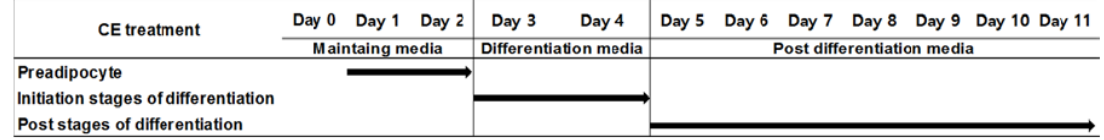
Figure 1. Experimental design to investigate the stimulatory effects of cinnamon extract (CE) treatments at different stages of 3T3-L1 adipocyte adipogenesis. 3T3-L1 adipocytes were treated with CE at the preadipocyte (days 1–2), initiation (days 3–4), and post stages (days 5–11) of differentiation during adipogenesis. When adipocytes were fully differentiated and matured on day 11, cells were harvested to extract total RNA for measuring gene expression using quantitative real-time PCR and were stained with Oil-Red O to visualize lipid accumulation as a marker of differentiation.